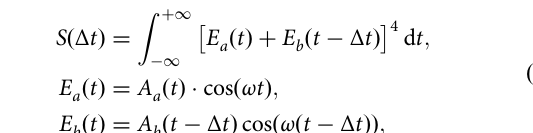
Fig. 2 Cross-polarized two-photon photoemission in the density matrix formalism. a Two-photon photoemission in a three-level system via real or virtual ! (cid:3) μ ! . b Illustration of the two-photon photoemission process in the density matrix for real ( ρ intermediate states for non-vanishing dot product E pathways) and virtual ( ρ 13 , ρ 31 , outer pathways) intermediate states. Electrons are excited into the fi nal state along every possible pathway of the matrix under all permutations of the electric fi elds. c Direction of the in-plane electric fi elds with regard to a fi xed orientation of the optical transition dipoles yielding the angles φ 12 and φ 23 , which have to be applied accordingly along the